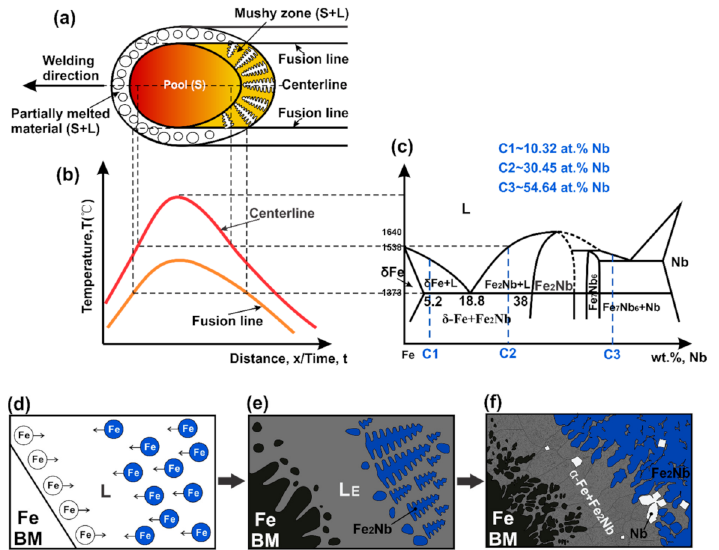
Figure 7. Schematic diagrams showing the progression of the phase transformations in Nb weld metals during the solidification: ( a ) microstructure of the solid plus liquid around the weld pool; ( b ) thermal cycles; ( c ) part of Fe–Nb binary phase diagram; ( d – f ) microstructure transformations in the Fe-rich portion. L: liquid; S: